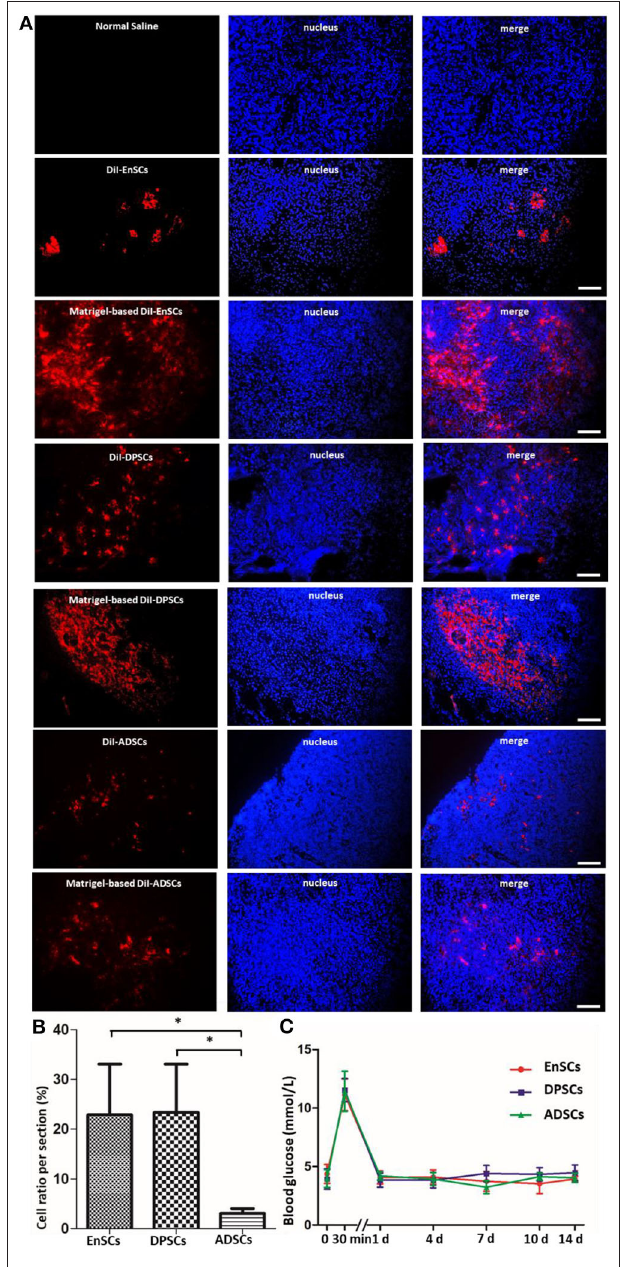
FIGURE 5 | MSCs from three sources at day 14 post orthotopic injection into pancreatic parenchyma of SD rats. (A) Representative fluorescence micrographs of cryo-sections in the EnSCs (upper panel), DPSCs (middle panel) and ADSCs (bottom panel) engraftment groups 14 days after orthotopical transplantation into pancreatic parenchyma of SD rats, respectively. DiI fluorescence, red; DAPI fluorescence, blue. Scale bar = 20 µ m. (B) The average ratios of Matrigel-based CM-DiI-labeled cells counted in the pancreatic cryo-sections. Shown in the histogram were the percentages of Matrigel-based CM-DiI-labeled MSCs in the three groups compared to the total nuclei. * p < 0.05. (C) Blood glucose levels in SD rats transplanted orthotopically with Matrigel-based hEnSCs, Matrigel-based hDPSCs, and Matrigel-based hADSCs. Shown are the average blood glucose levels of the tail tip measured and plotted for each time